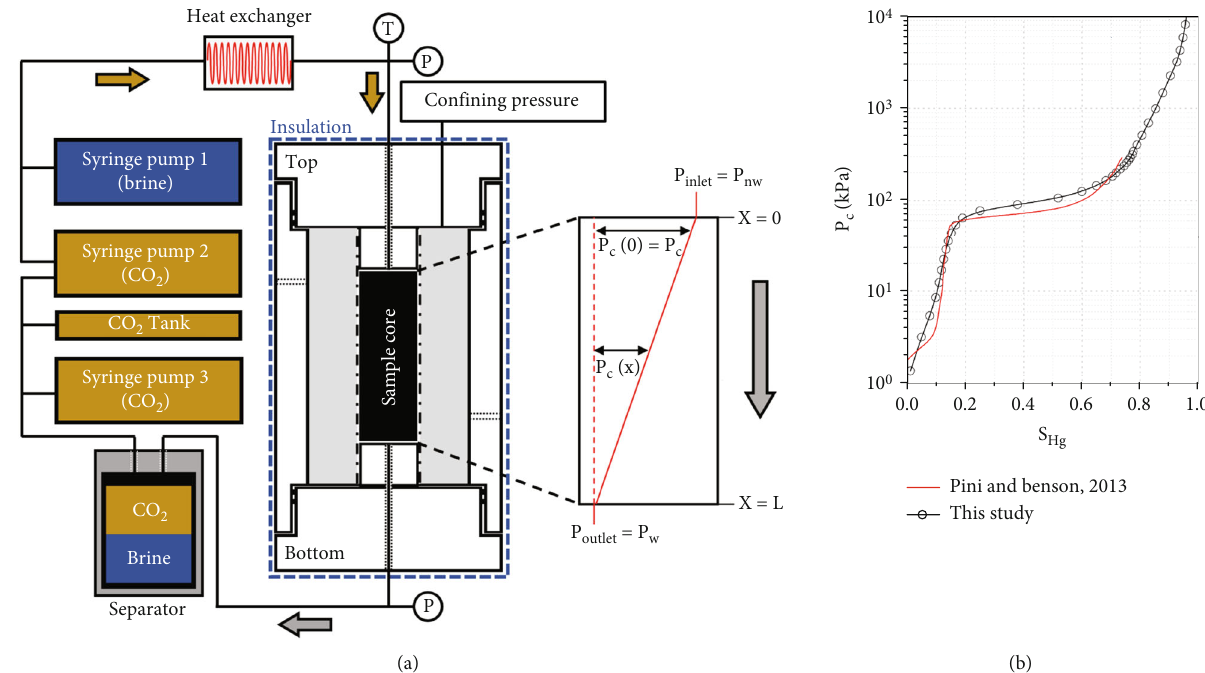
Figure 2: (a) Experimental setup and pressure diagram of CO P and P . (b) Mercury injection porosimetry (MIP) curve for Berea sandstone. Note that S inlet outlet